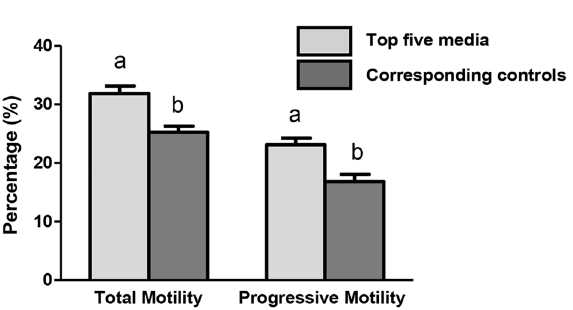
Figure 5. Average of total and progressive motilities between top five media recipes and their corresponding values for control extenders (split sample) in four bulls ( n = 20). Error bars indicate SEM. A significantly higher percentage of total and progressive motilities were observed in these selected extenders compared to standard control extenders (p < 0.05; different letters in each category). Total motility and progressive motility were measured by computer assisted semen analysis (CASA).